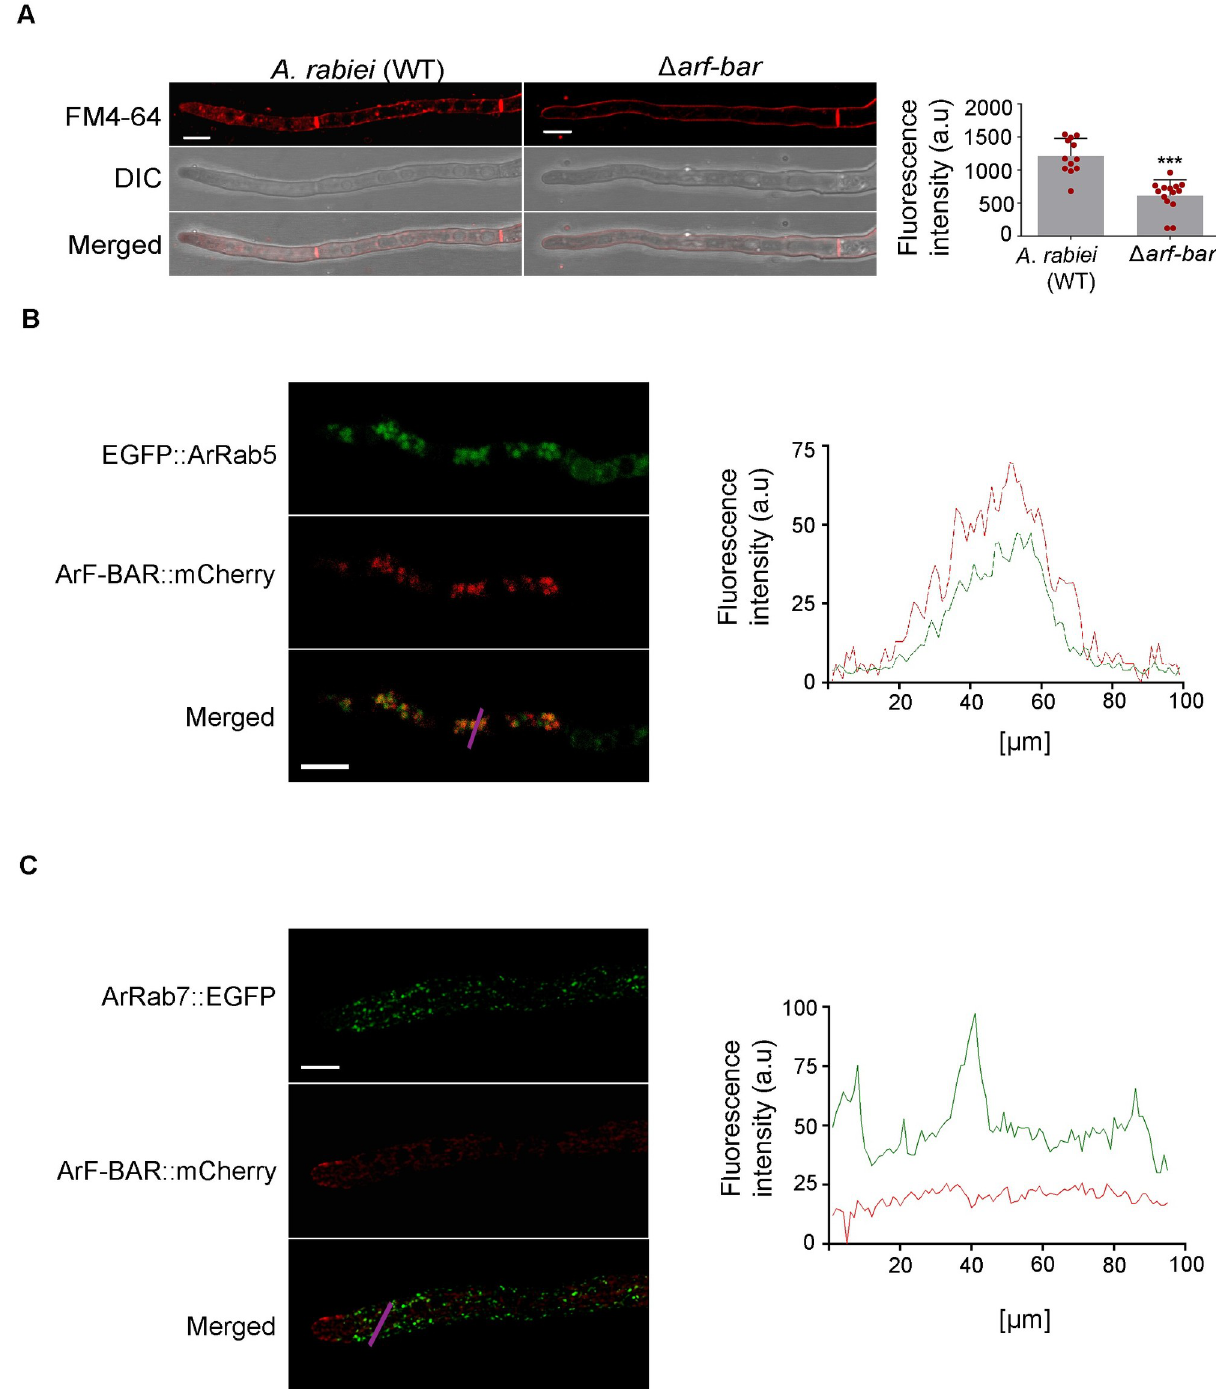
Fig 6. ArF-BAR facilitate endocytosis. (A) Confocal images of A . rabiei (WT) and Δ arf-bar hyphae after 10 min incubation with FM4–64 to acquire internalization capacity. Scale bar = 5 μ m. Right panel represents the bar graph of FM4-64 fluorescence intensity per unit area mean value (a. u = arbitrary unit) in WT A . rabiei (1210.78 ± 256.18) and Δ arf-bar mutant (604.092 ± 246.62) strains hyphae after internalization of the dye. The significance of mean fluorescence intensities variation was statistically examined using one-tailed paired t-test, ��� p = 0.0002. Red dots represent the value of each replicate. (B) Confocal images showing co-localization of ArF-BAR::mCherry with EGFP::ArRab5 (n = 22), scale bar = 10 μ m. Right panel shows the positive correlation between the fluorescence intensity of ArF-BAR (Red) with ArRAB5 (Green) across the magenta line in merged panel. (C) ArF-BAR does not localizes with the late endosome marker ArRab7::EYFP. The representative image is the maximum intensity projection of all z -stack